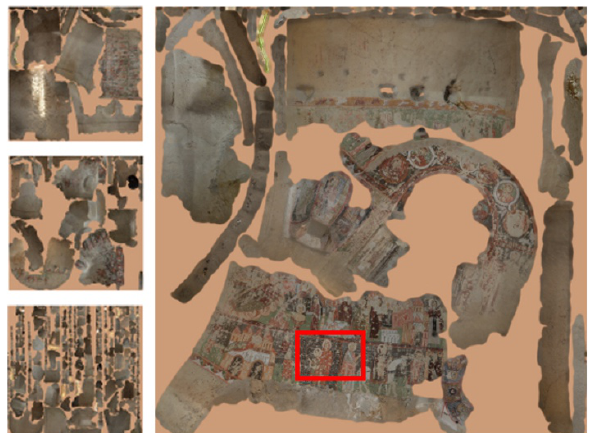
Figure 3. Four textures of wall-paintings of Agios Eustathios